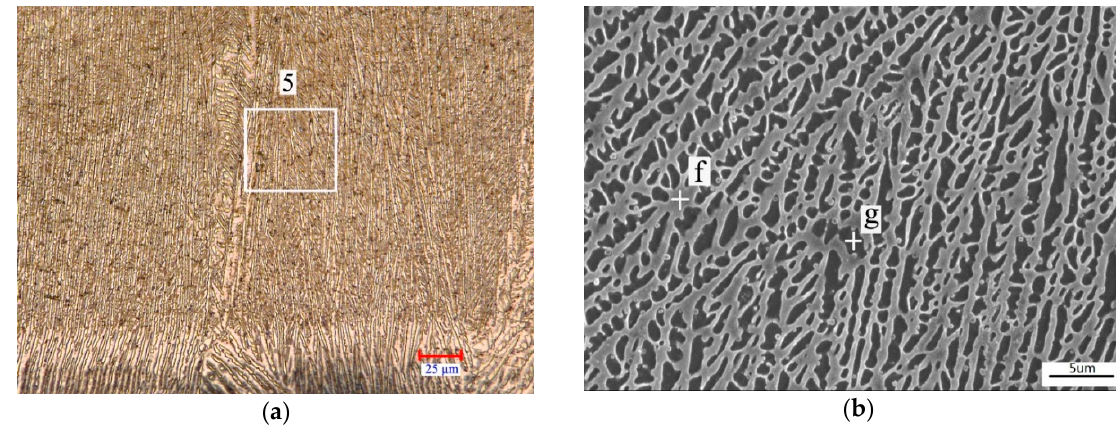
Figure 6. Typical microstructure morphologies of Coating 2: ( a ) OM image of Coating 2; ( b ) Amplification of region 5 in image ( a ).